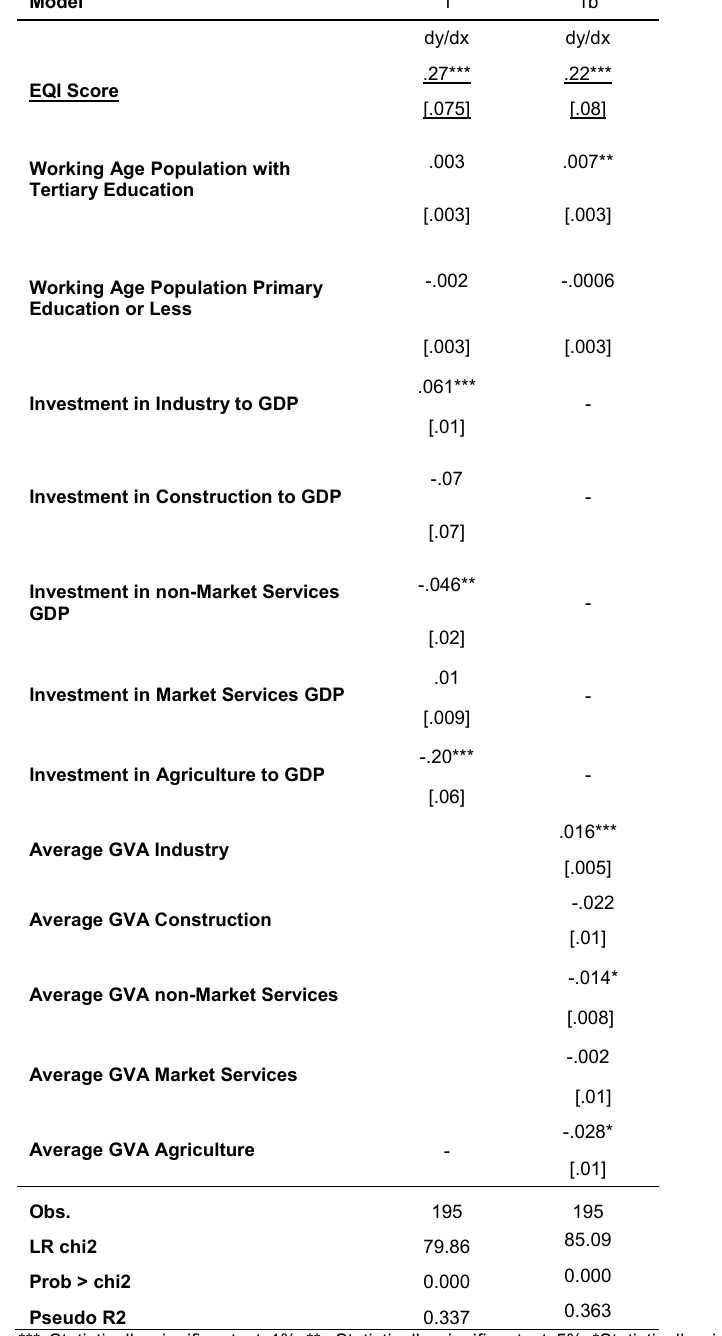
Table 2. Marginal effects on probability Y=1|X. Group